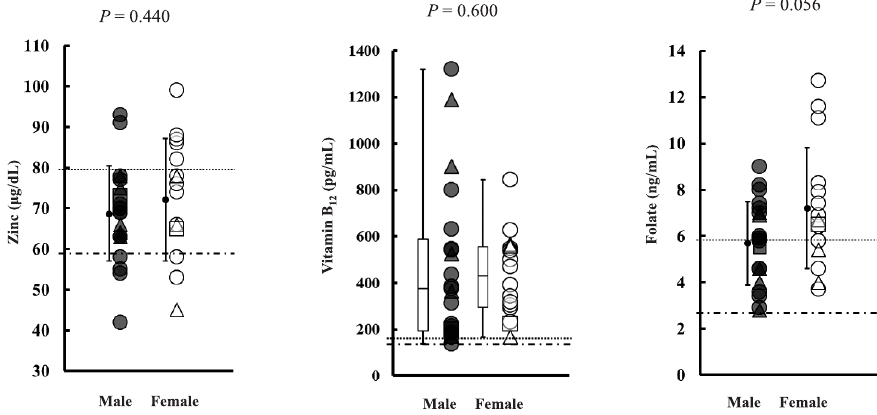
Figure 3 Relationship between sex and serum levels of zinc, vitamin B 12 and folate. Circles: Malignant lymphoma. Triangles: Leukaemia. Squares: Multiple myeloma. Zinc and folate were expressed as means±standard deviations. Vitamin B 12 was expressed as medians with interquartile ranges. Dotted lines show cut- off values between sufficient and potentially deficient values. Chain lines show cut-off values between potentially deficient and